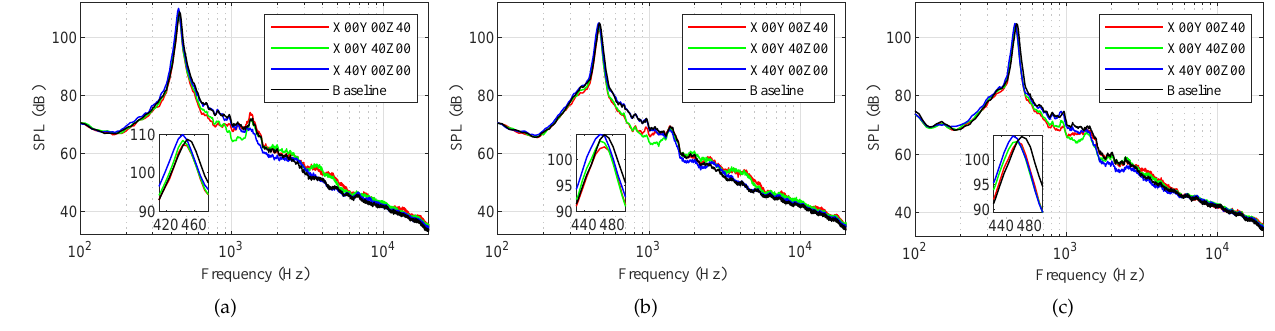
Figure 11. Typical noise spectra for different porous positions ( V ∞ = 50 m/s): ( a ) L = 100 mm, α = 0 ◦ ; ( b ) L = 200 mm, α = 0 ◦ ; and ( c ) L = 200 mm, α = 10 ◦